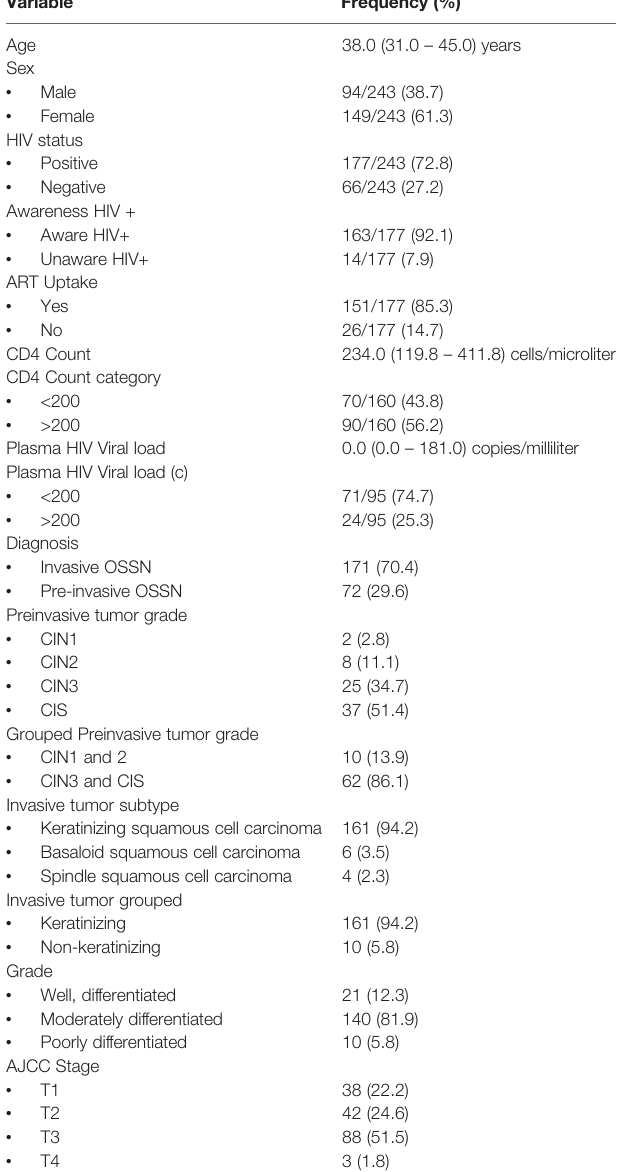
TABLE 1 | Clinicopathological characteristics of the participants and their